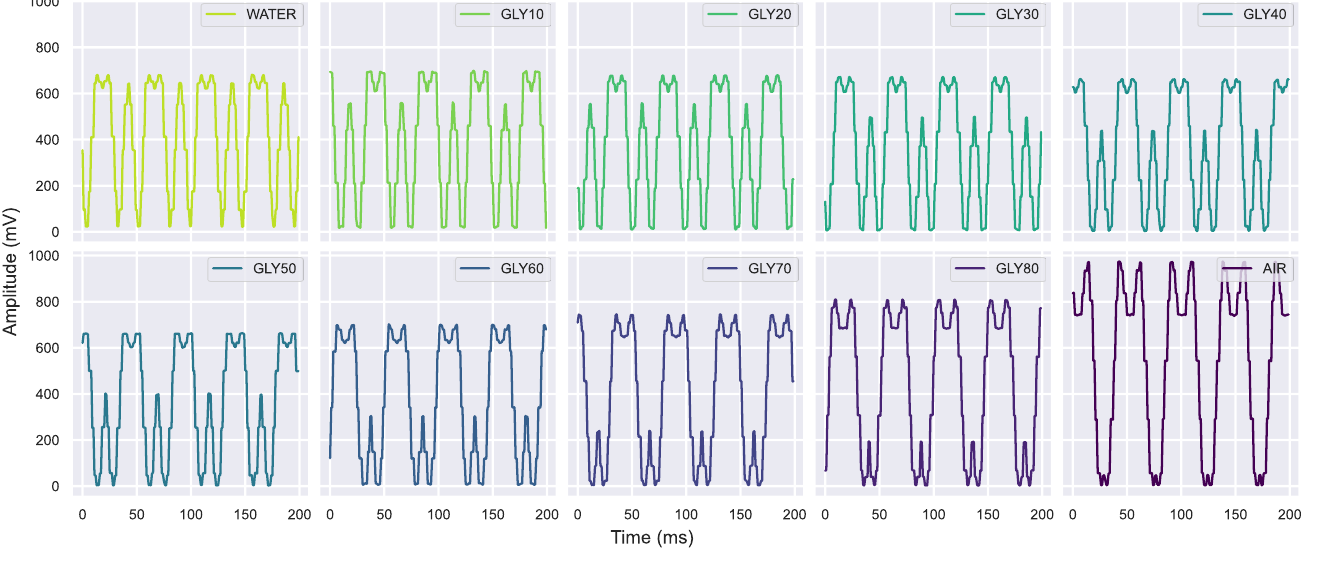
Figure 8. The electronic reader signals examples for each glycerin concentration and air.